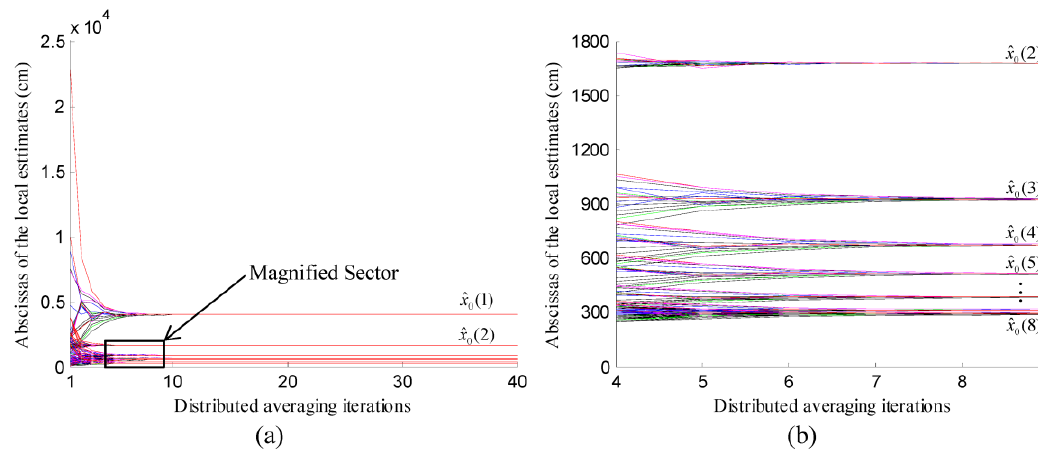
Figure 7. The variation of the abscissas of local estimates in eight successive iterations of localization. To get a clear illustration, the sector surrounded by the black rectangle in ( a ) is magnified and displayed in ( b